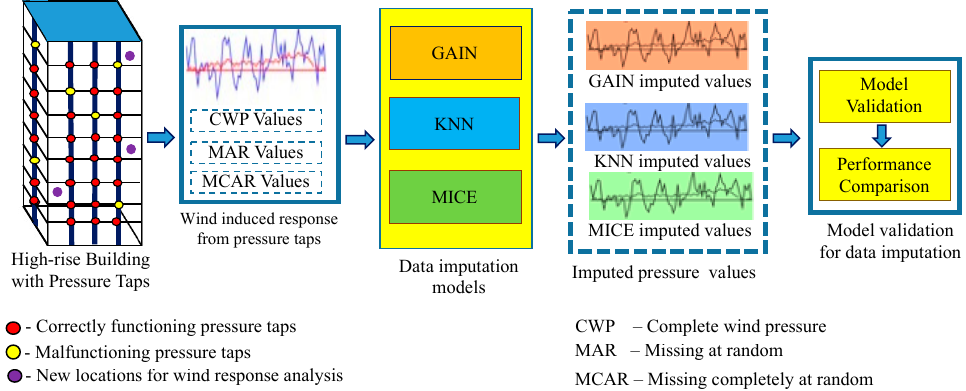
Figure 7. Data imputation models and performance comparison.